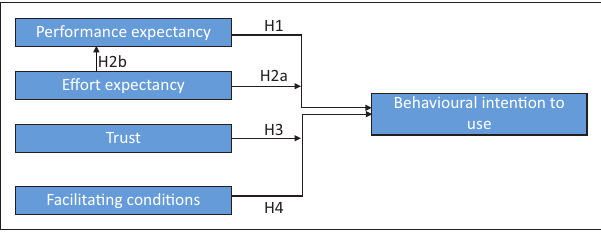
FIGURE 1: Research model.